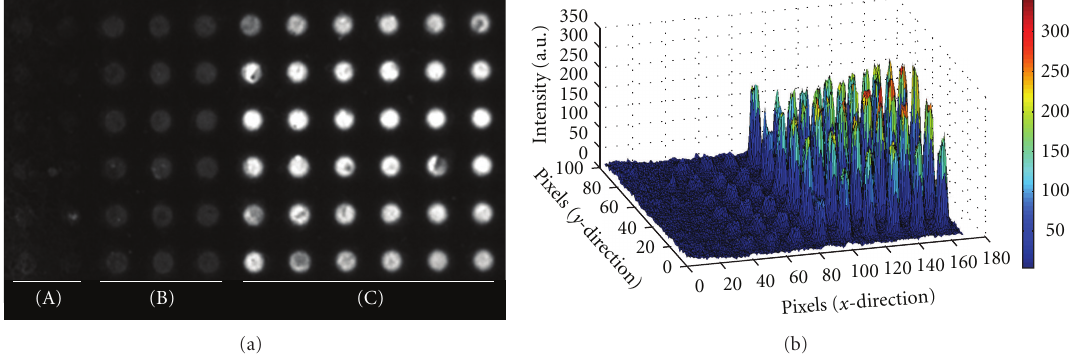
Figure 3: (a) Fluorescence image of a section of the CMOS microarray after addressing 39 combined layers of biotin NPs and GOx-avidin. (A) No current applied. (B) Current applied ONLY when biotin NPs were addressed. (C) Current applied when BOTH biotin NPs and GOx-avidin were addressed. (b) Corresponding MATLAB plot of the relative fluorescence intensity ( z -axis) of each